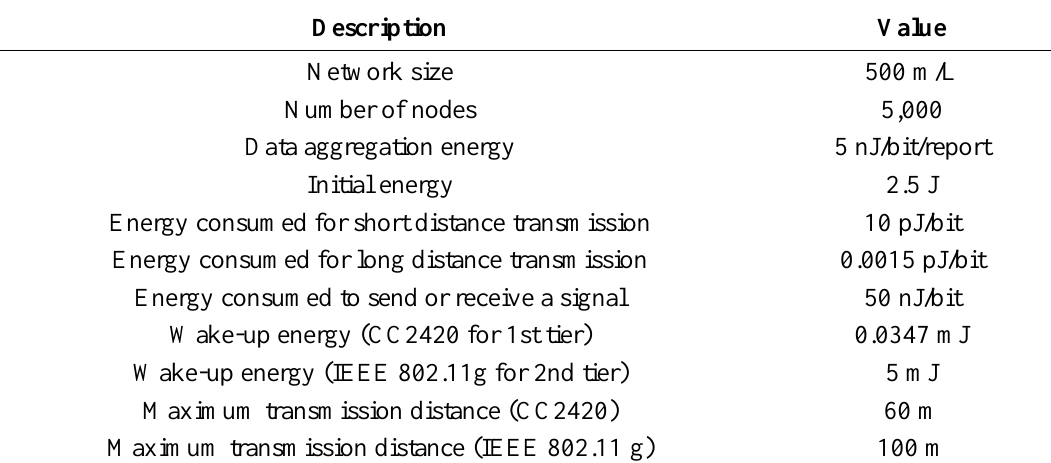
Table 1. Simulation parameters.